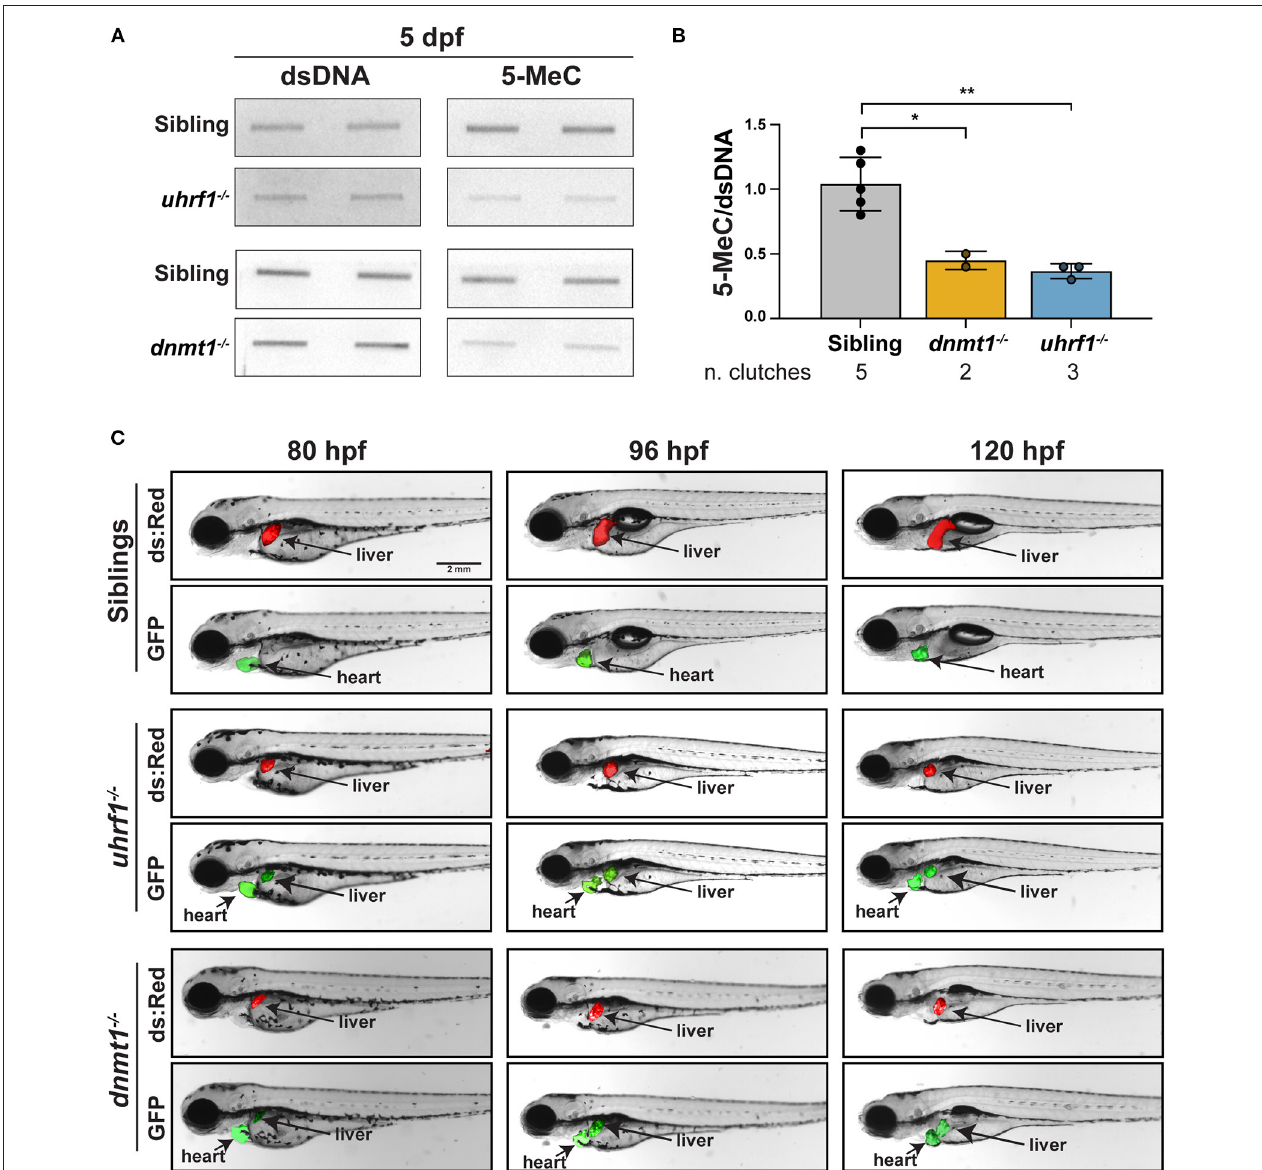
FIGURE 1 | uhrf1 and dnmt1 loss causes DNA methylation loss in zebrafish livers. (A) Slot blot of genomic DNA extracted from pools of 5 dpf uhrf1 − / − and dnmt1 − / − mutant and WT siblings livers. (B) Quantification of 5-MeC measured by slot blot normalized to double stranded DNA (dsDNA). Each dot represents one clutch. * p < 0.05 and ** p < 0.005 calculated by unpaired t -test. (C) Time course imaging of live larvae by fluorescent stereoscope microscopy. Tg(c269 ◦ ff ; 10XUAS:dsRed; fabp10a:GAL4; cmlc2:EGFP);dnmt1 − / − and Tg(c269 ◦ ff; 10XUAS:dsRed; fabp10a:GAL4; cmlc2:EGFP);uhrf1 − / − are shown at each age, showing the liver (dsRed), the heart (GFP) as a marker of transgenesis and, in green, the liver with DNA hypomethylation in mutants only. Images are representative of 100% of larvae from 3 clutches observed for each